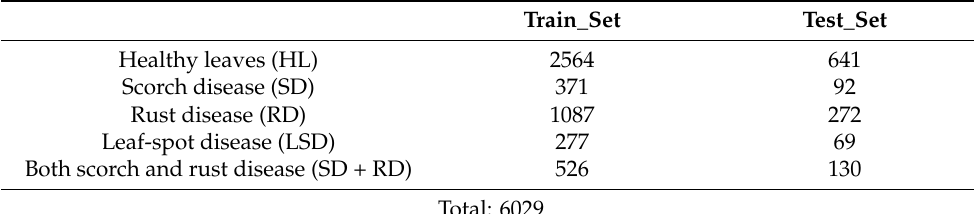
Table 1. Information for the division of